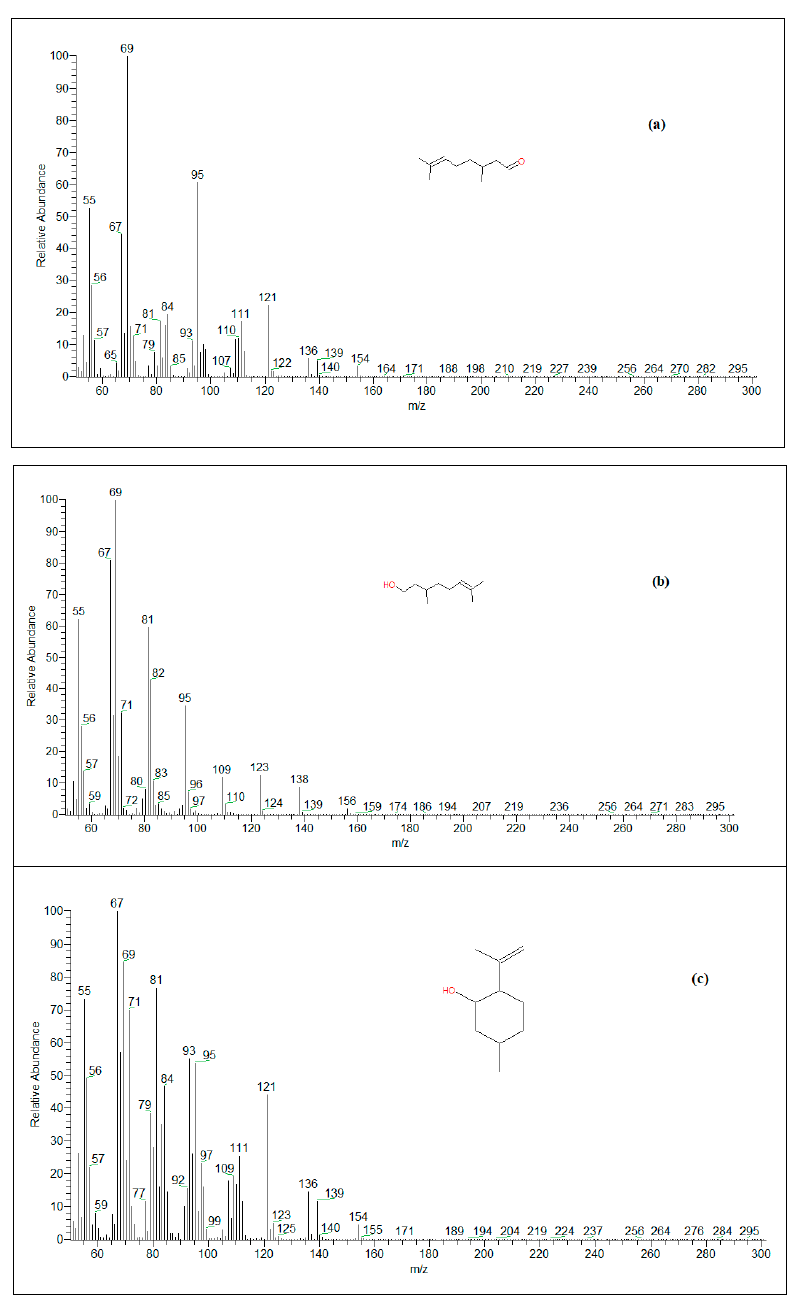
Figure 1. The 70 eV mass spectrum of ( a ) citronellal, ( b ) citronellol, and ( c ) isopulegol in C. citriodora leaves’ essential oil. M stands for mass and Z stands for charge number of ions.